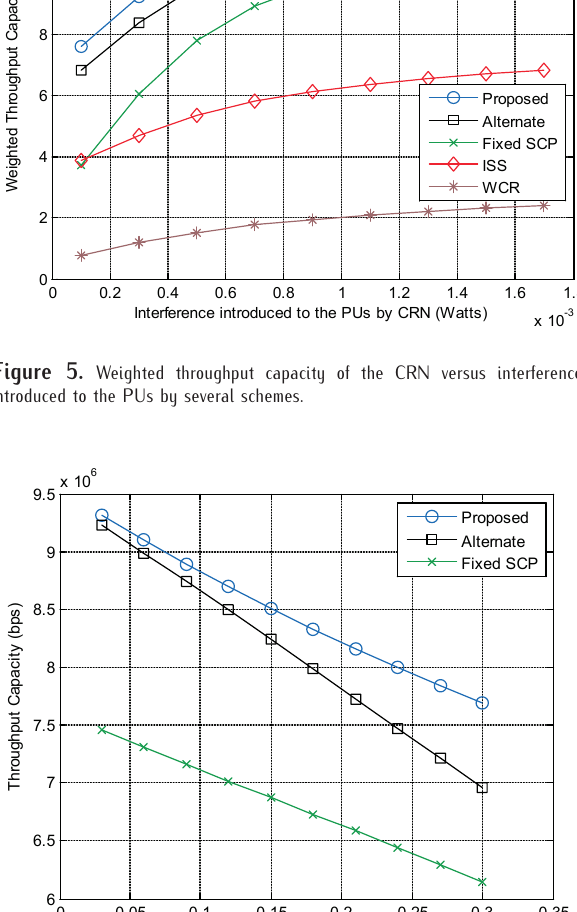
expected, since quality of spectrum sensing (false alarm probability) is not considered for the achievable total rate, performance of the main proposed scheme, alternate scheme, and ISS scheme are very close to each other. However, as can be understood from Fig. 3, spectrum sensing results are di ff erent in these